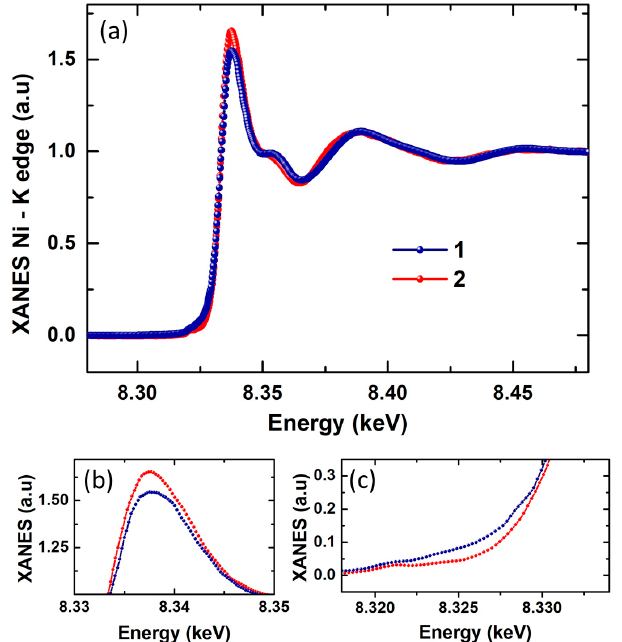
Figure 5. ( a ) X-ray absorption near-edge structure spectroscopy (XANES) around the Ni K-edge in 1 – 2 ; ( b , c ) detailed XANES spectra at the Ni K-edge showing the difference between 1 and 2 at the